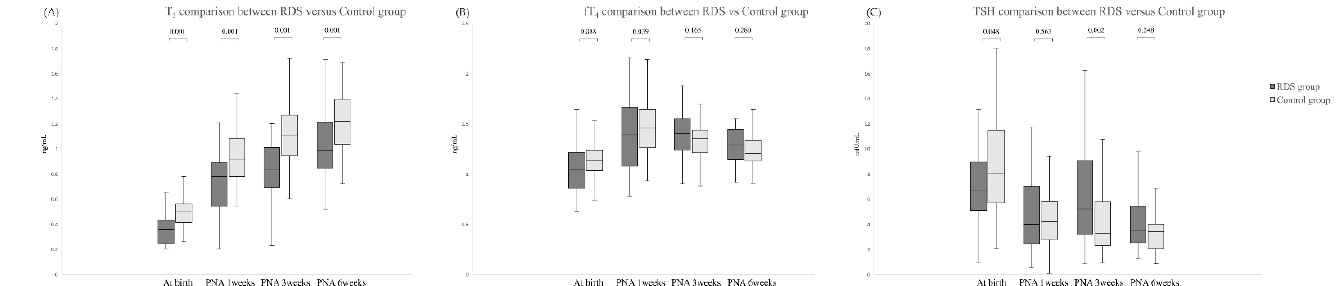
Figure 2. Thyroid hormone levels by postnatal age. ( A ) Triiodothyronine (T 3 ) levels increased up to 6 weeks after birth. T 3 levels were lower in the RDS group on the day of birth and 1, 3, and 6 weeks after birth. ( B ) Free thyroxine (fT 4 ) was higher, but not significantly so, in the control group at birth. One week after birth, fT 4 was significantly lower in the RDS group. ( C ) Thyroid-stimulating hormone levels were higher in the RDS group at birth, but there was no significant difference 1 week after birth.